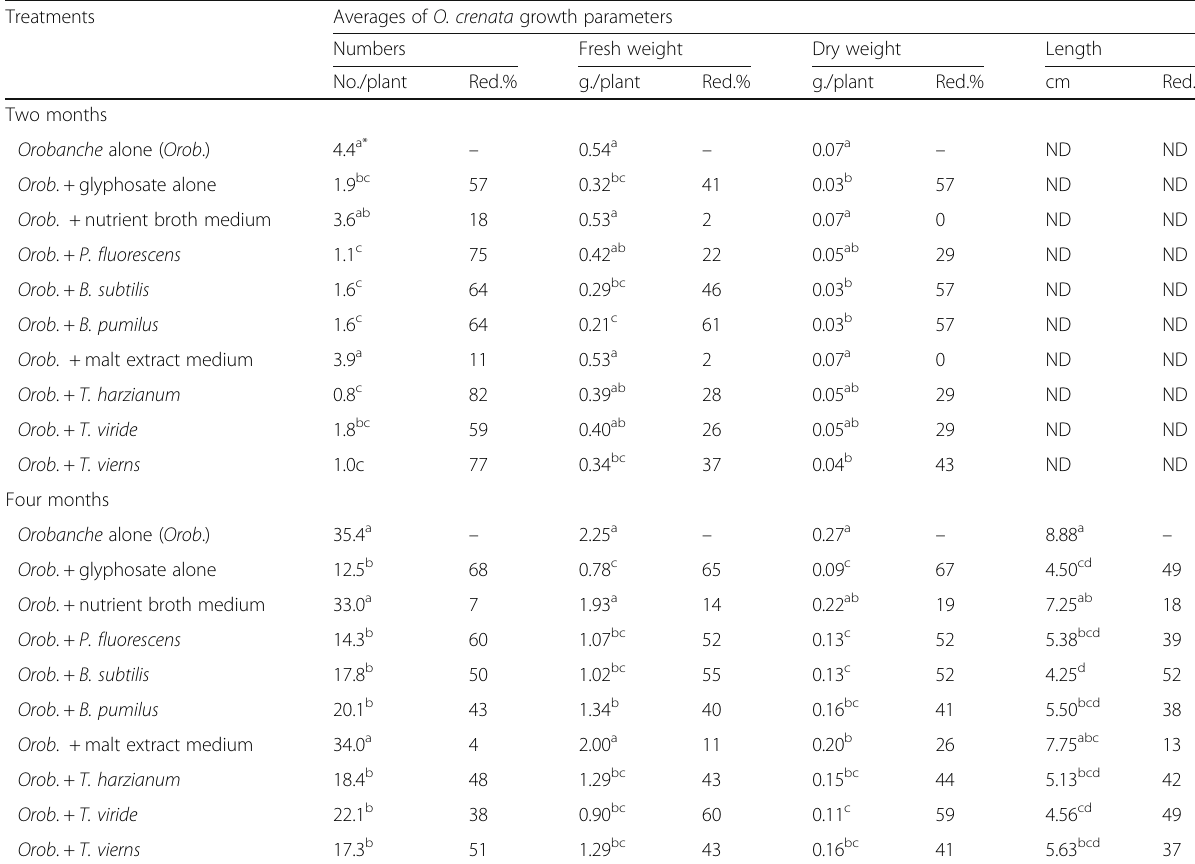
Table 2 Effects of plant growth-promoting bacteria and Trichoderma species on O. crenata growth parameters in faba bean under greenhouse conditions (Experiment II)